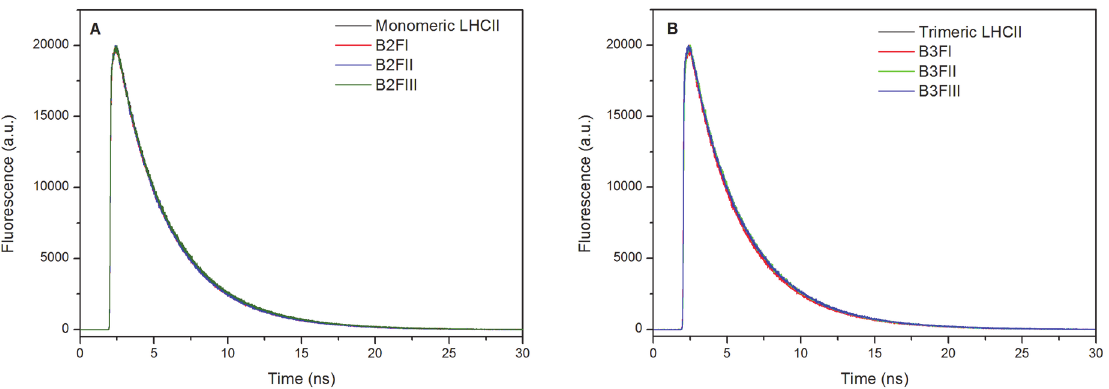
Fig 4. Time-Resolved Fluorescence Decay kinetics of the ndIEF fractions. (A) monomeric complexes; (B) trimeric complexes.